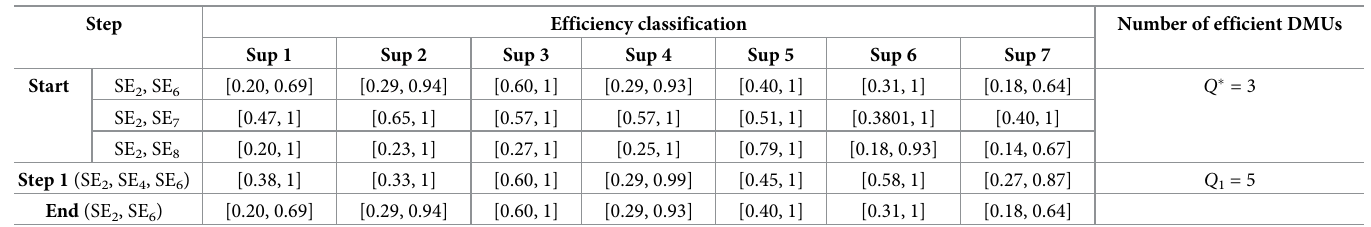
Table 9. Results of the forward-stepwise